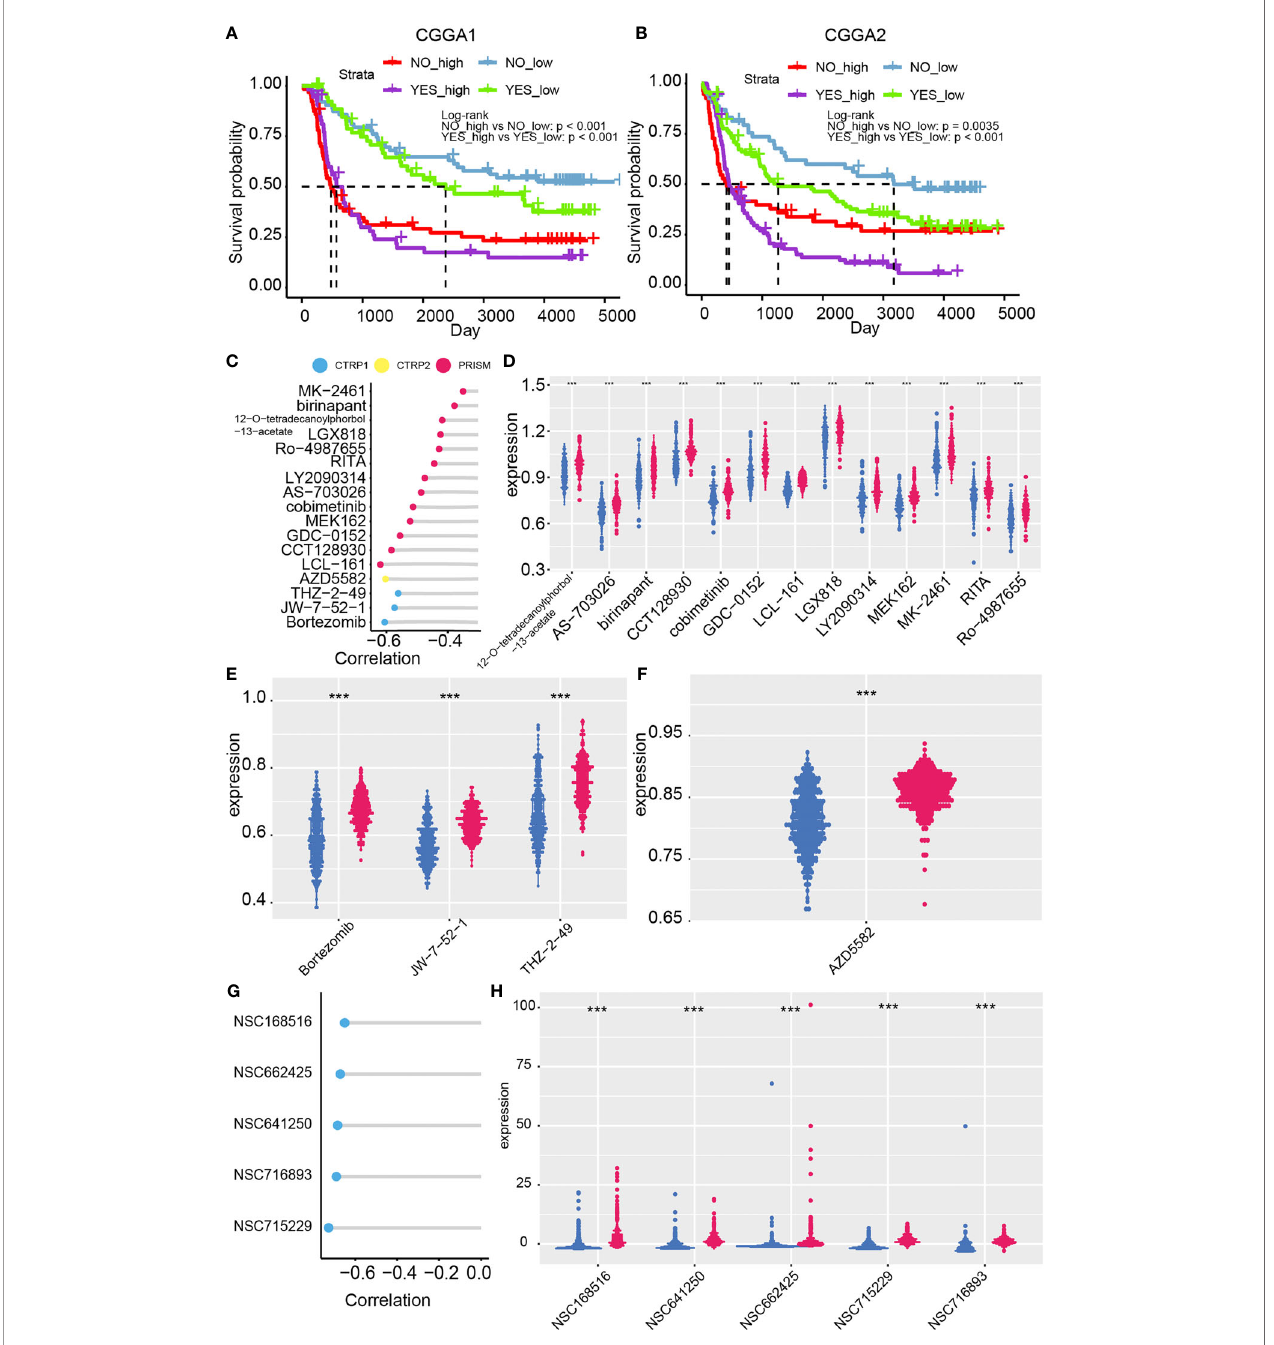
FIGURE 6 | Chemotherapy suggestion based on the risk model. Chemotherapy ef fi cacy difference between high- and low-risk group in the CGGA1 (A) and CGGA2 (B) datasets. (C) Correlation between risk and the AUC value of 17 candidate compounds. (D – F) Distribution of the AUC value of candidate compounds in the risk model. (G) Correlation between compounds ’ IC50 and risk from Cellminer dataset. (H) The difference between IC50 of compounds and the risk model ***p <